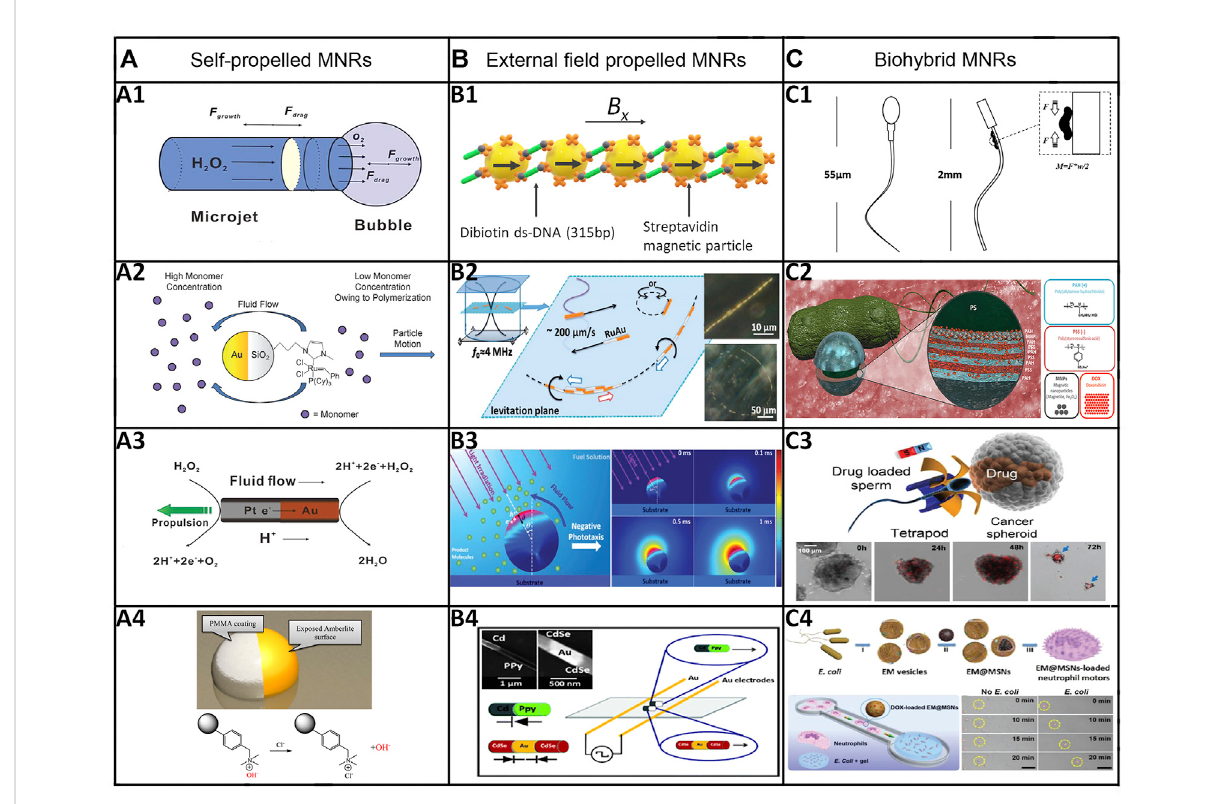
FIGURE 2 Categories and representative examples of MNRs. (A) Chemically-powered MNRs. (A1) Bubble propulsion: tubular catalytic microrobot propelled by O 2 -bubble ejection in an aqueous H 2 O 2 solution. (Manjare et al., 2013) Copyright 2013. Reproduced with permission from American ChemicalSociety.(A2)Self-diffusiophoresis:polymerization-poweredmicrorobot.(Pavlicketal.,2011)Copyright2011.Reproducedwithpermission from John Wiley and Sons. (A3) Self-electrophoresis: Au ‒ Pt bimetallic nanorod propelled by a self-electrophoresis mechanism in an aqueous H 2 O 2 solution (Paxton et al., 2004). Copyright 2004. Reproduced with permission from American Chemical Society. (A4) Surface tension gradient: autonomous motors powered by the rapid depolymerization reaction of poly (2-ethyl cyanoacrylate) (PECA). (Zhang et al., 2013) Copyright 2013. Reproduced with permission from American Chemical Society. (B) External- fi eld-powered MNRs. (B1) Magnetic fi eld: magnetic fi eld propelled micromotor (Dreyfus et al., 2005). (B2) Ultrasound: metallic micro-rods propelled by ultrasound. (Wang et al., 2012) Copyright 2012. Reproduced with permission from American Chemical Society. (B3) Light: an isotropic TiO 2 microrobot powered by UV light. (Chen et al., 2017) Copyright 2017. Reproduced with permission from John Wiley and Sons. (B4) Electric fi eld: rod-like nanorobots powered by an electric fi eld. (Calvo-Marzal et al., 2010) Copyright 2010. Reproduced with permission from The Royal Society of Chemistry. (C) Biohybrid MNRs. (C1) Muscle cells: a muscle-cell- driven hybrid microrobot (Williams et al., 2014) (C2) Bacteria: bacteria-driven microswimmers based on polyelectrolyte multilayer (PEM) magnetic nanoparticles attached to an E. coli MG1655 bacterium. (Park et al., 2017) Copyright 2017. Reproduced with permission from American Chemical